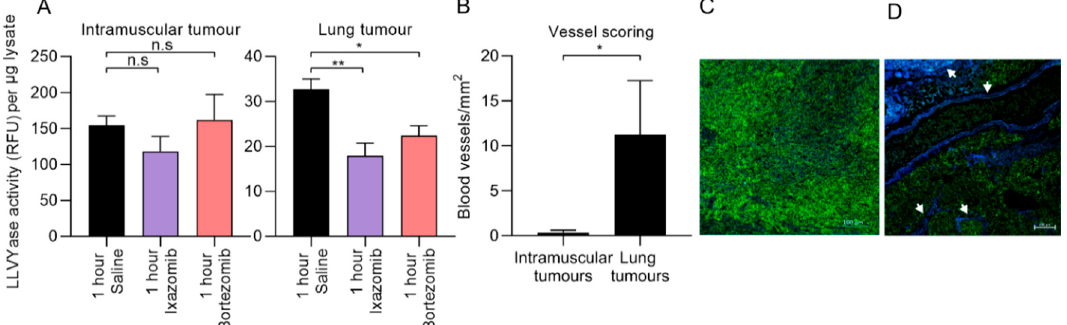
Figure 4. Ixazomib and bortezomib inhibit the proteasome activity of vascularized lung tumors but not poorly vascularized intramuscular tumors. Tumor tissue was resected one hour after mice were treated with either saline, ixazomib or bortezomib and assayed for LLVYase activity ( A ). Sections of primary tumor and lung tissue containing metastases were stained for CD44 (green) and CD31 (blue) positive cells to quantify blood vessels ( B). Arrows indicate blood vessels in representative pictures of stained primary tumor ( C ) and lung tumors ( D ). ( A ) One-way ANOVA with Holm-Sidak corrections were used to determine the likelihood that di ff erences in LLVYase activity in treated and untreated tissue samples were due to random chance. ( B ) An unpaired t-test was used to determine if the di ff erences in blood vessel counts between tissue types were due to random chance (n.s p > 0.05, * p < 0.05, ** p < 0.01; n = 2 biological replicates for LLVYase activity and 3 biological replicates for blood vessel scoring +/ − SEM). ( C , D ) Scale bars represent 100 µm.